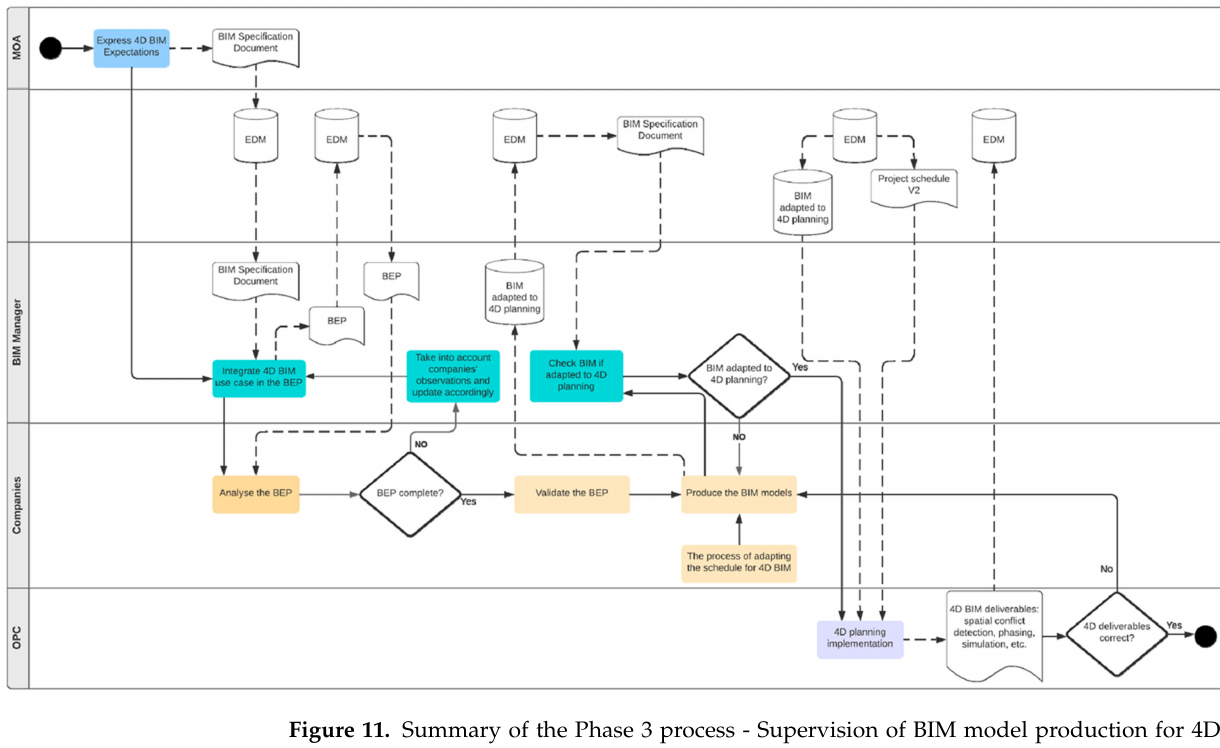
Figure 11. Summary of the Phase 3 process - Supervision of BIM model production for 4D BIM use case.